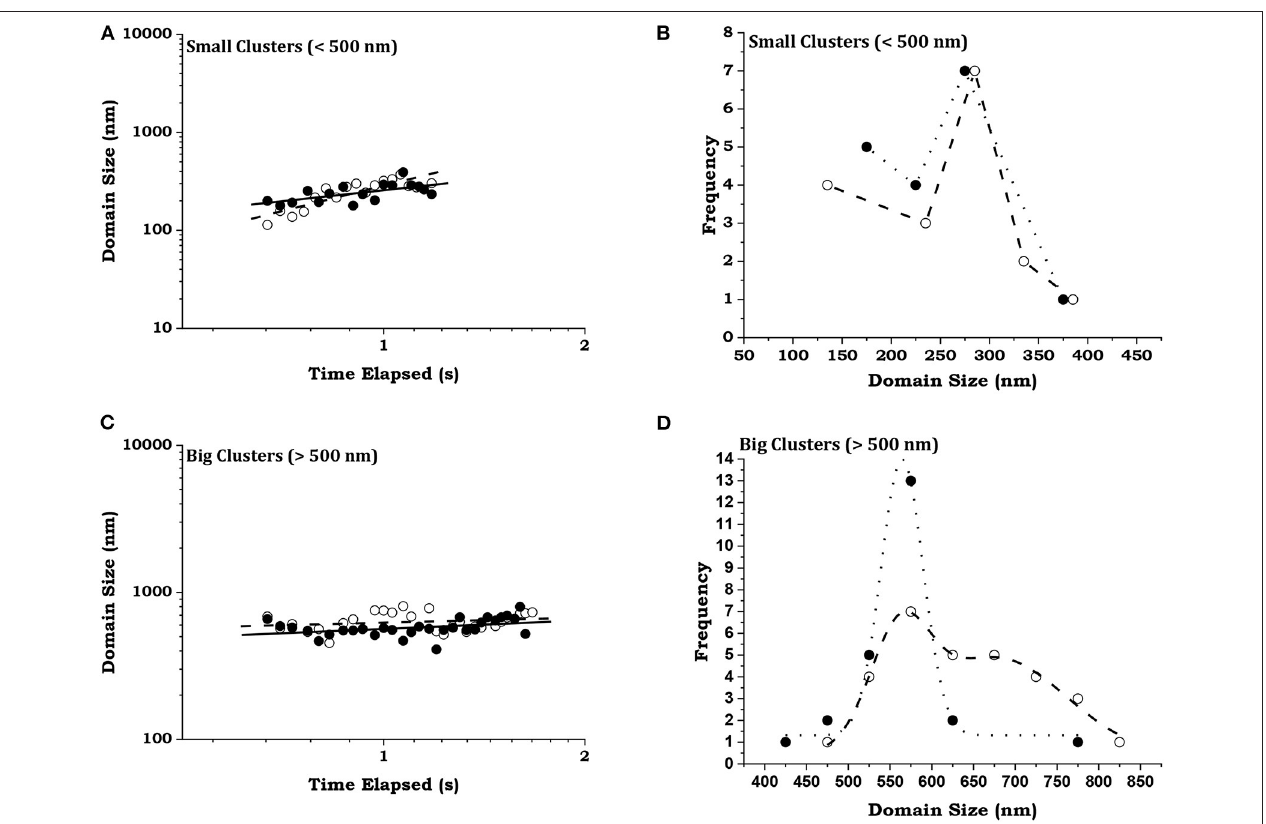
FIGURE 5 | Distribution of domains. Two randomly chosen members are represented by open and filled circles from (A) , (C) small (diameter < 500nm) and (B) , (D) big (diameter > 500nm) domains. The variations of domain size with time are shown as log-log plots in (A,B) , with dotted and dashed lines as fits to the data. The distributions of the domain sizes are shown in (C,D) with Gaussian simulations of the